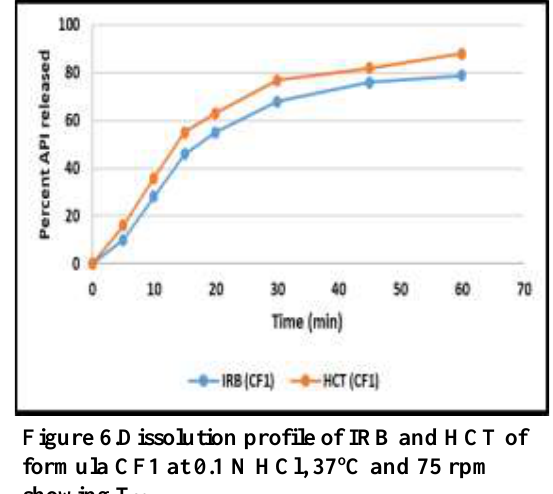
Table 9. T 30 of release of IRB and HCT from the uncoated formula and